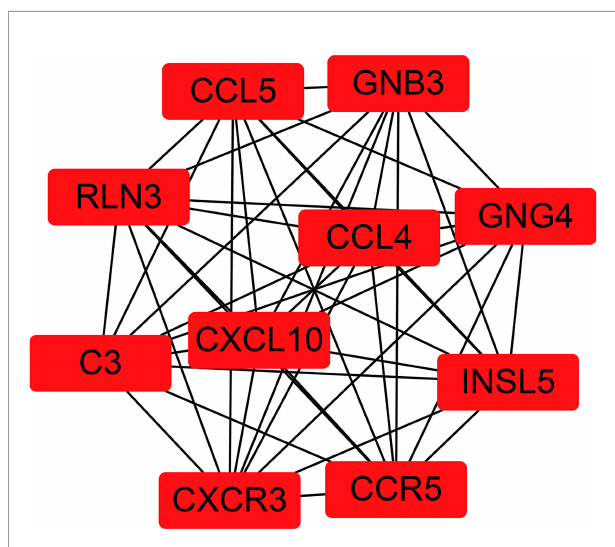
FIGURE 6 | The 10 most connected hub genes selected fromthe PPI